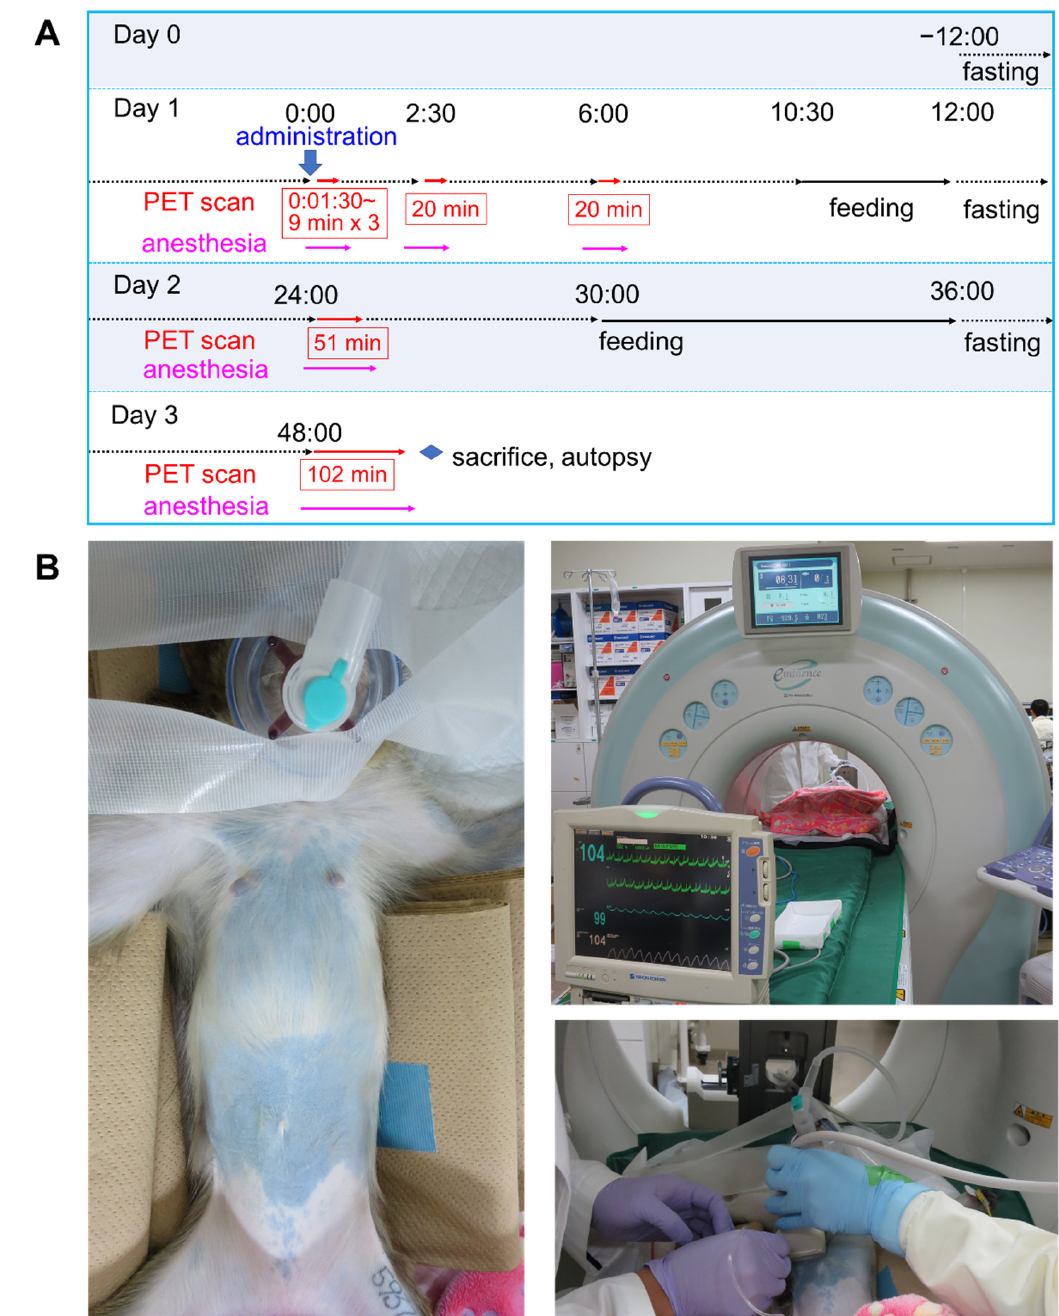
Figure 7. Time schedule and experimental setup of the monkey positron emission tomography (PET) scan. ( A ) Time schedule of the PET scans. Timing of the intraperitoneal (ip) administration is indicated as “0:00” of day 1. The PET scanning schedule is shown using red arrows and numbers. The anesthesia schedule is shown using pink arrows. ( B ) The experimental setup of a monkey PET scan. Experimental monkey under anesthesia (left), PET scanner and vital sign monitor (upper right), and ip administration route confirmation using an ultrasound scanner (lower right).